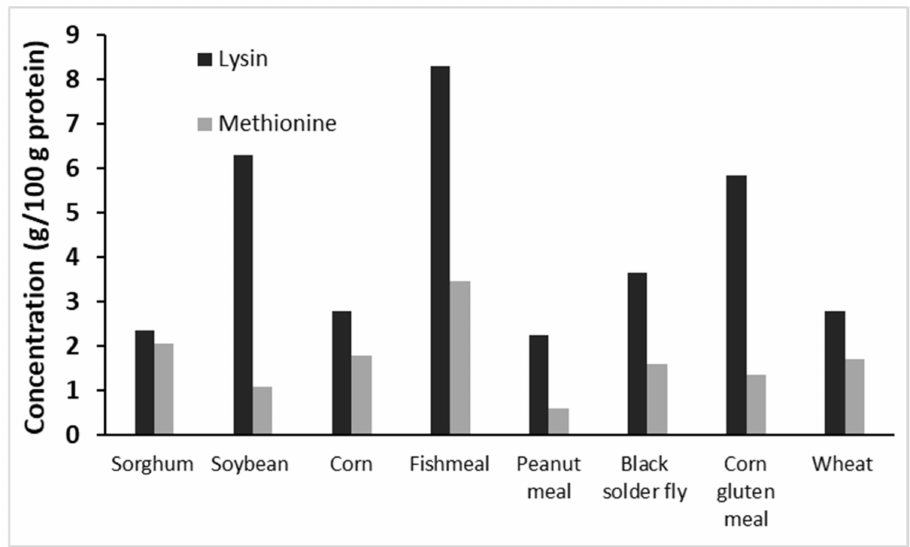
Figure 2. Lysine and methionine contents of common feed ingredients of aquafeed